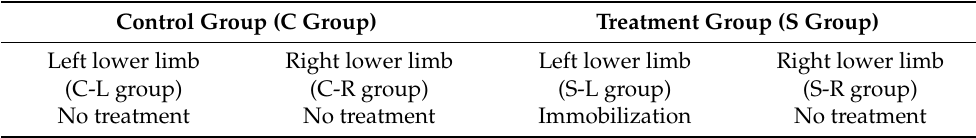
Table 1. Construction plan of disuse muscle atrophy